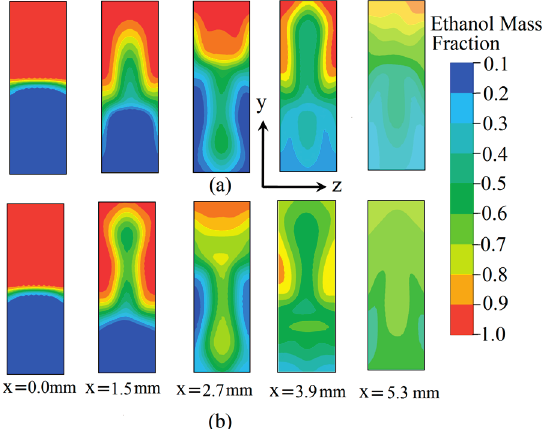
Figure 3. Concentration distributions of ethanol on y - z planes at various cross-sections (Re = 60): ( a ) two-split unbalanced rhombic micromixer, and ( b ) three-split unbalanced rhombic micromixer.